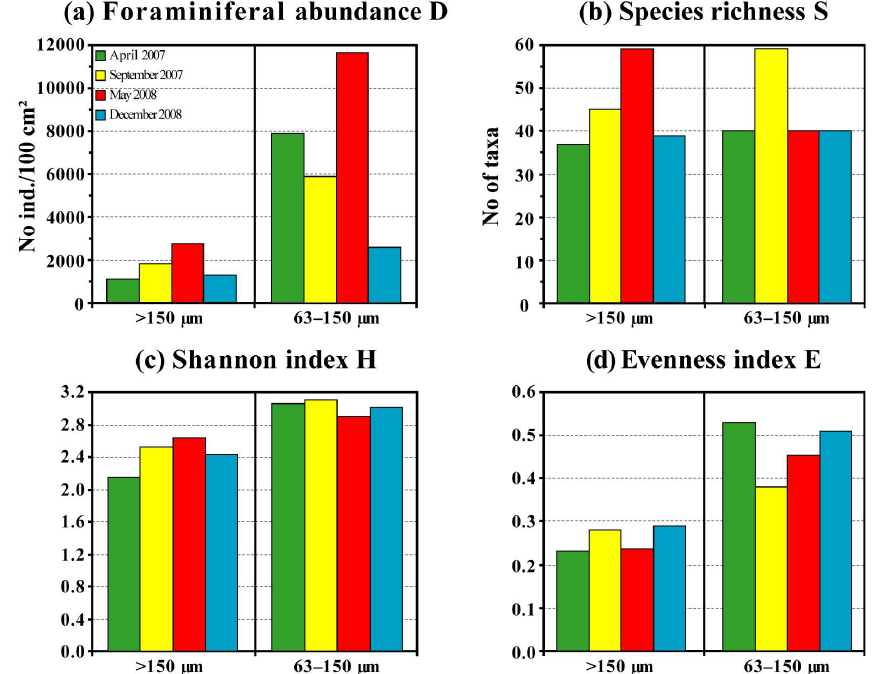
Fig. 7. Foraminiferal abundance D standardised for a surface area of 100cm 2 (core surface: 72cm 2 ; sediment depth: 0.5cm for the 63– 150µm size fraction and 5cm for the > 150µm size fraction) (a) , species richness S (b) , Shannon index H (c) and Evenness index E (d) of the total living foraminiferal faunas in the > 150µm and 63–150µm size fractions at Station N for the four sampling